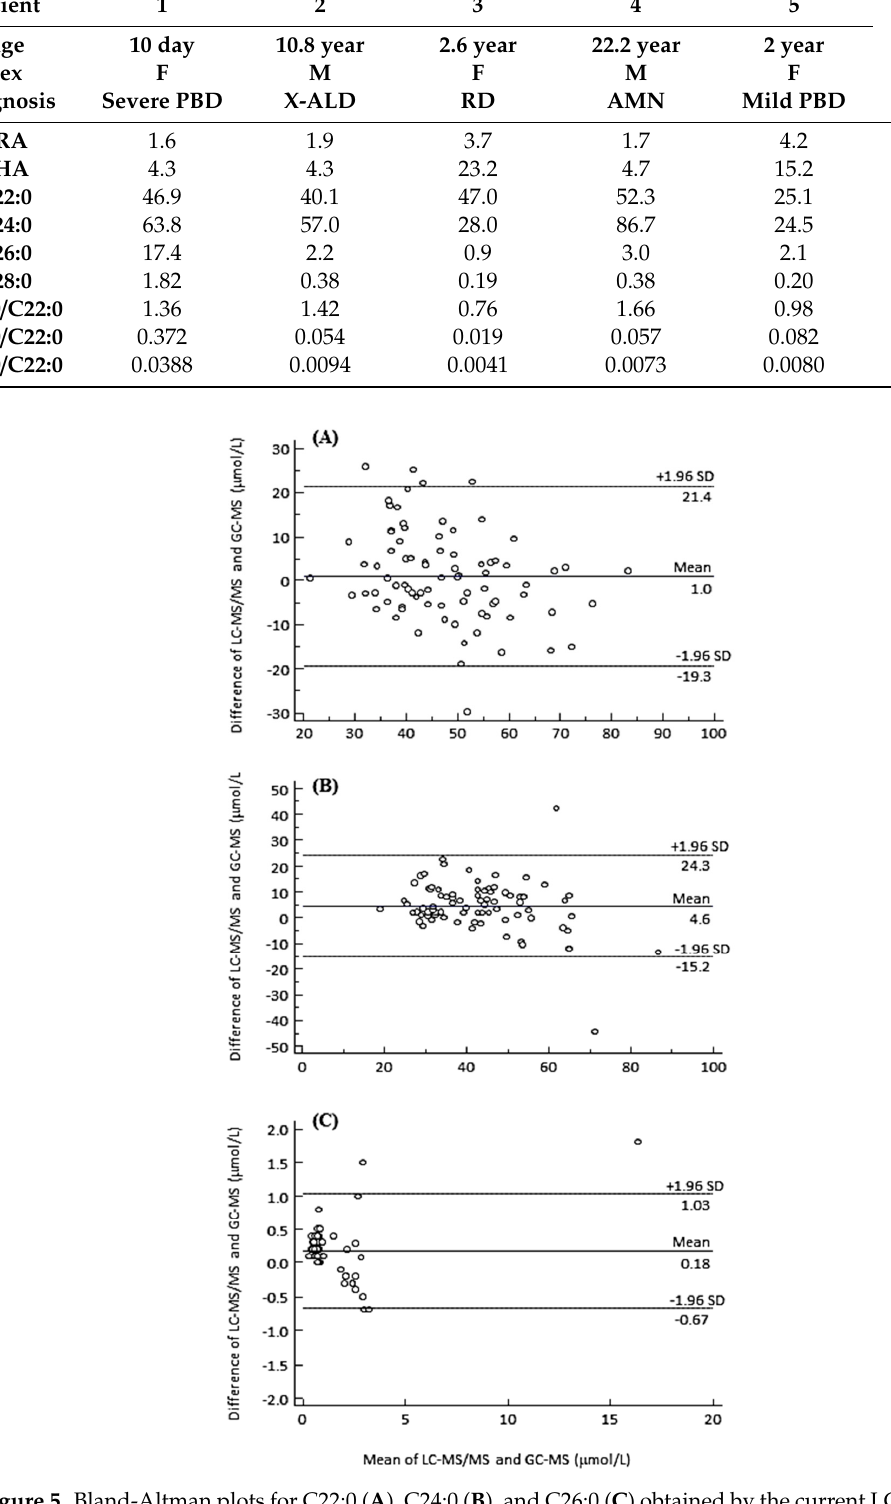
Figure 5. Bland-Altman plots for C22:0 ( A ), C24:0 ( B ), and C26:0 ( C ) obtained by the current LC-MS / MS method, and the routine GC-MS method. The x -axis shows the mean concentration, and the y -axis shows the di ff erence in concentration of the two methods.